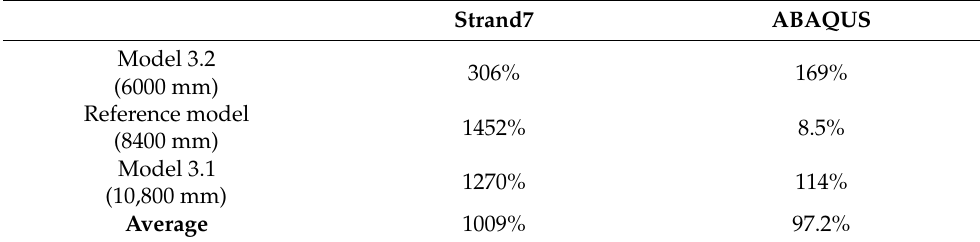
Table 20. Possible error between different approaches (change in secondary beam length).